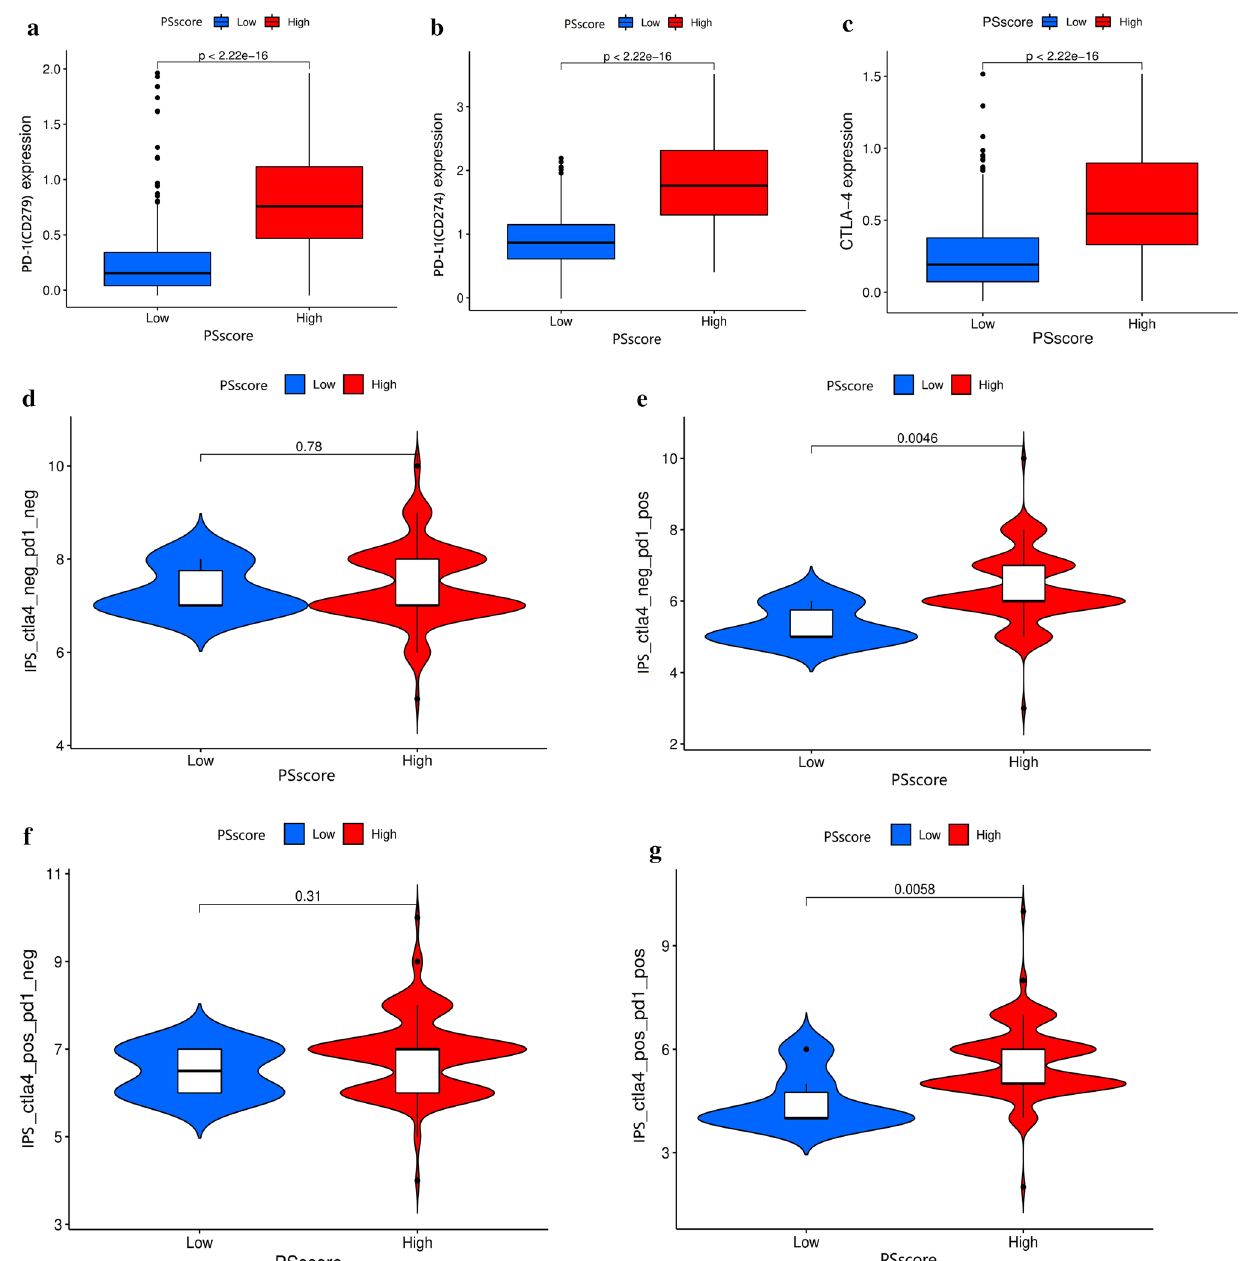
noscore ( IPS) difference between low and high PSscore groups in the anti-CTLA4 response and anti-PD1 no-response subtype cohort. g The immunophenoscore ( IPS) difference between low PSscore and high PSscore groups in the anti-CTLA4 and anti-PD1 double response